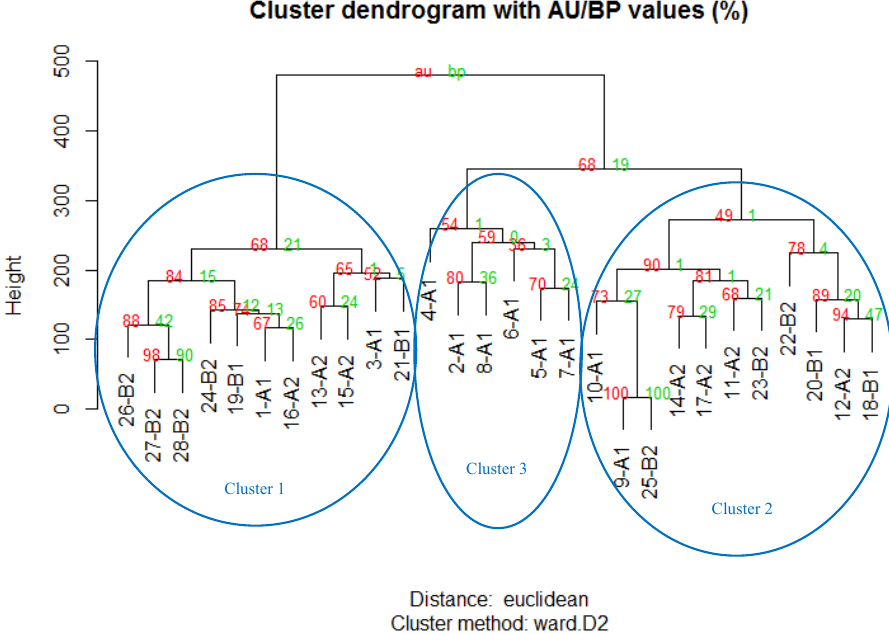
Figure 3. Cluster analysis of the 28 Spanish learners (including their corresponding CEFR language proficiency level) based on the percentages of canonical and non-canonical transcriptions per target vowel obtained from the listener data.